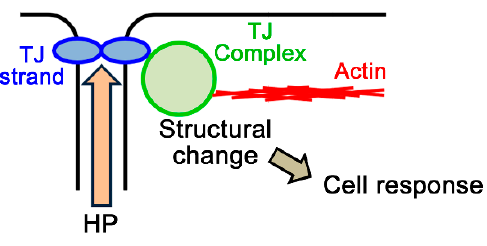
Figure 5. Possible mechanism of TJs as a sensor.